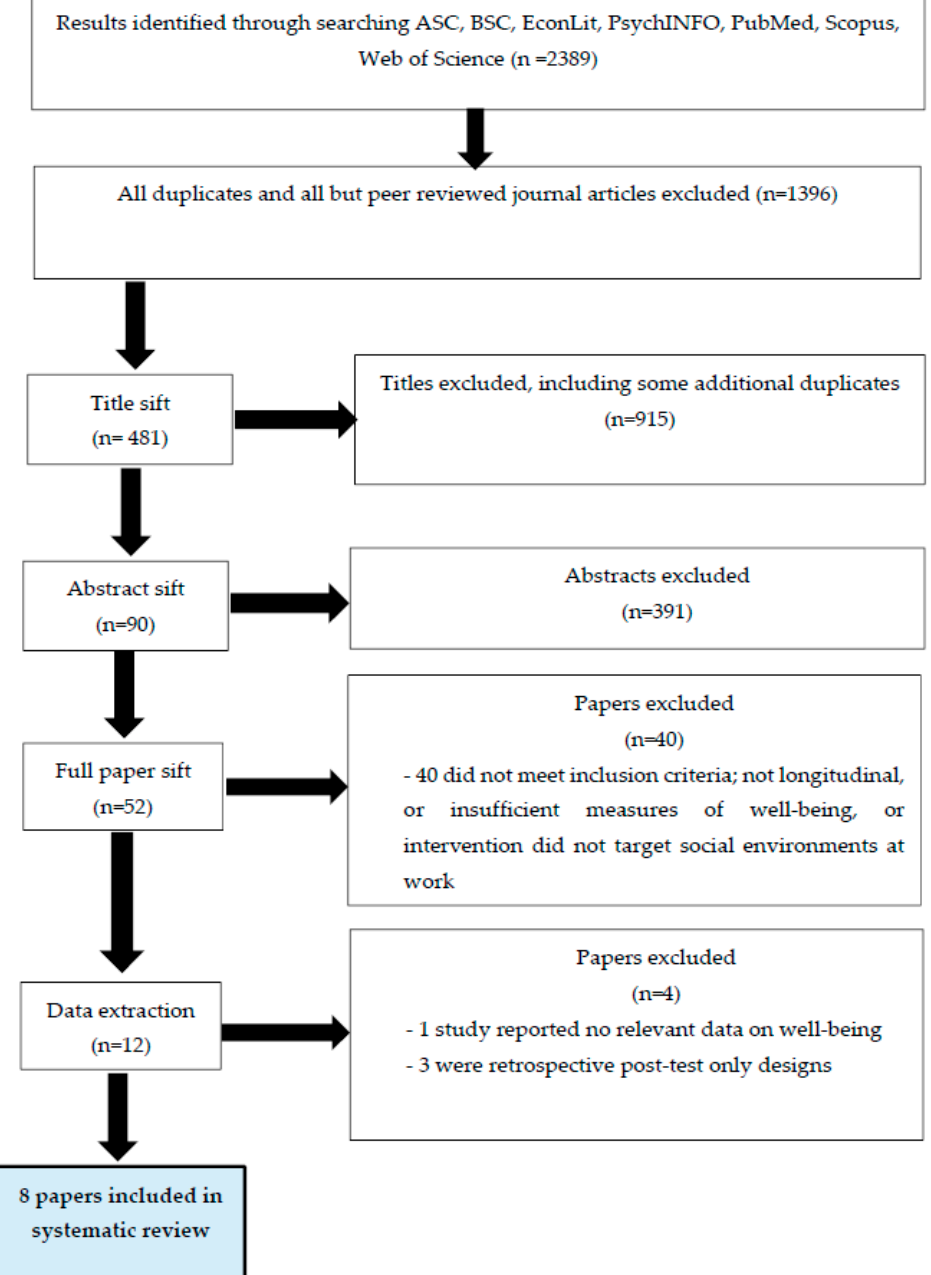
Figure 1. Study selection.